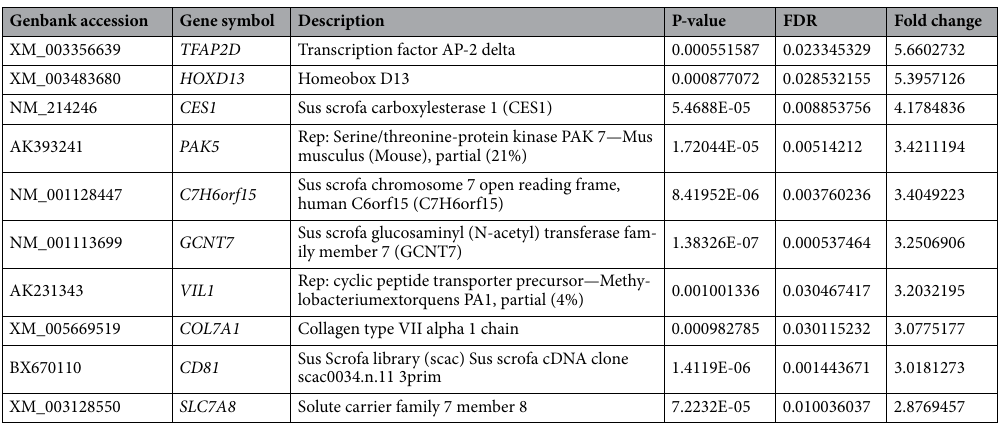
Table 1. The top ten differential genes with